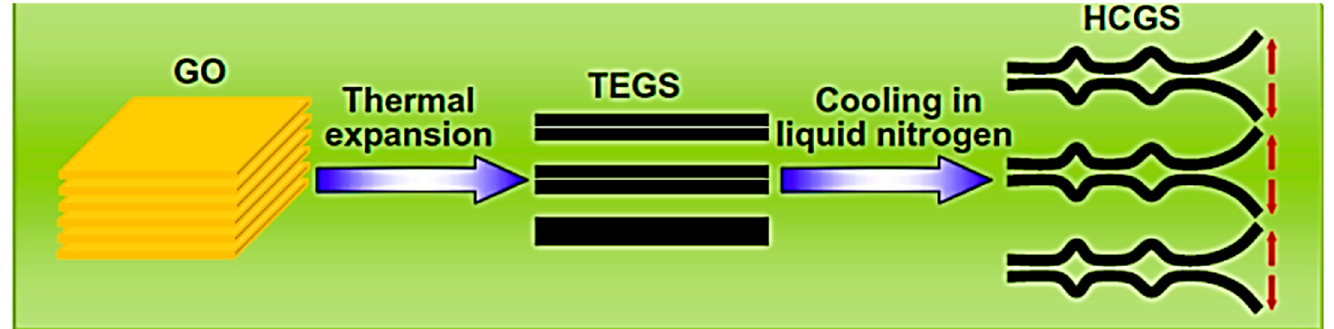
Figure 1. Schematic of formation of TEGS and HCGS [42]. GO = graphene oxide; HCGS = highly corrugated graphene sheets; TEGS = thermally exfoliated graphene sheets. Reproduced with permission from Elsevier.